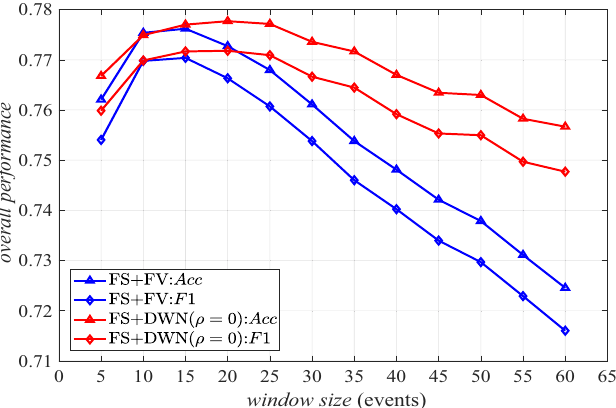
Figure 6. Overall performance of FS + FV and FS +DWN ( ρ =